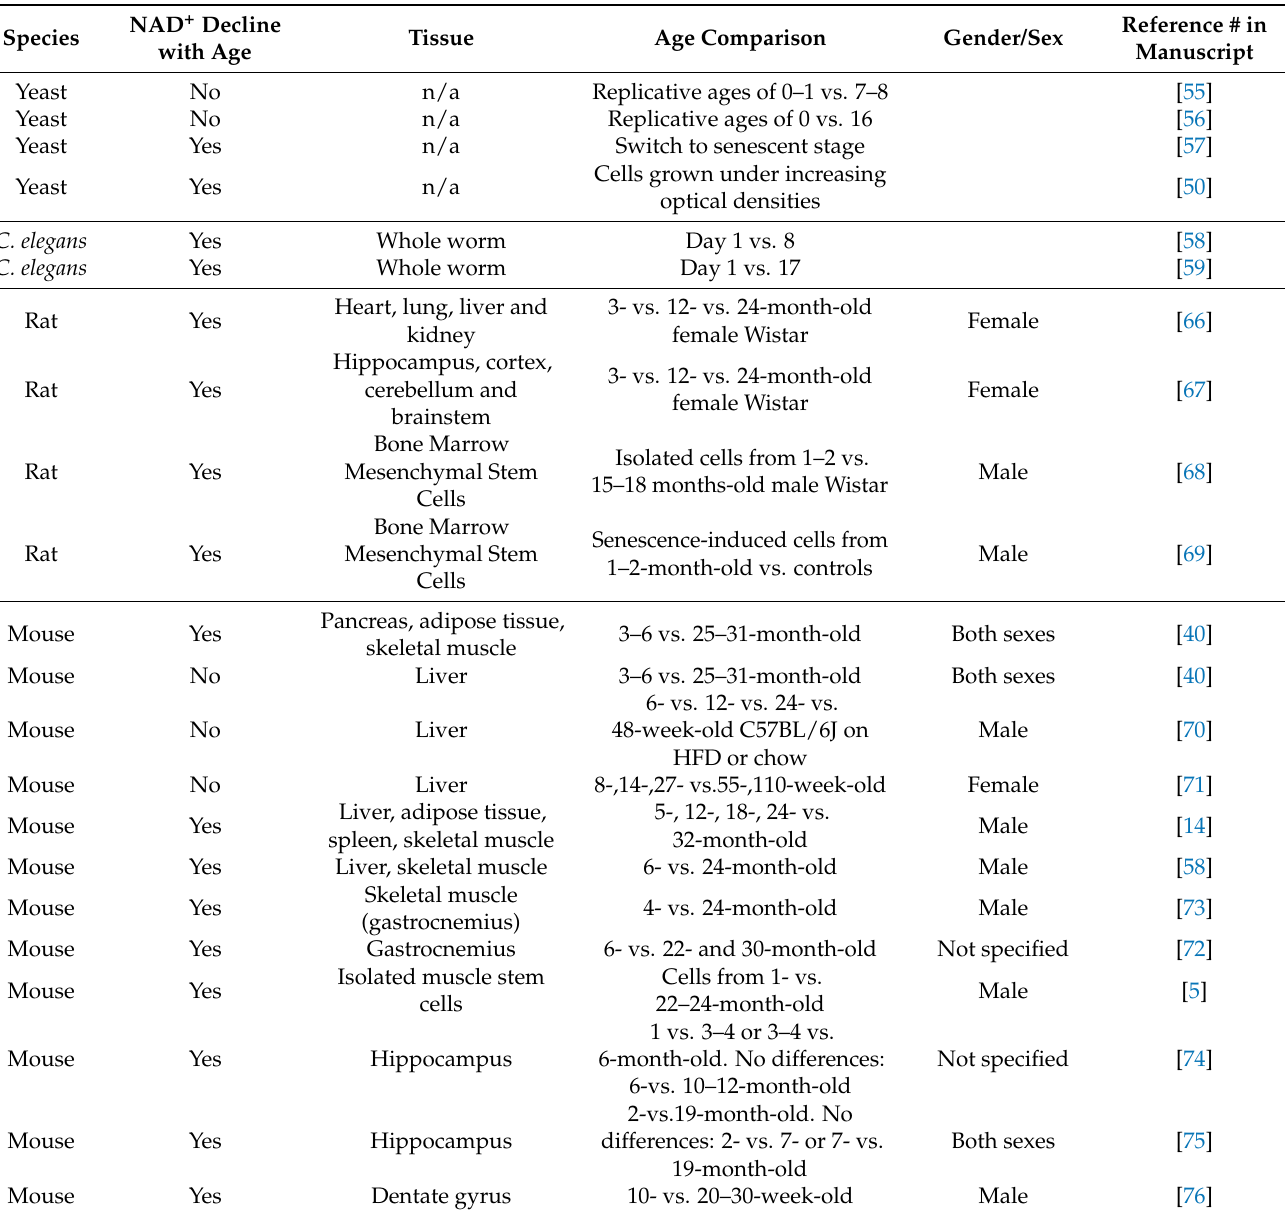
Table 1. Overview of studies reporting on NAD + levels with